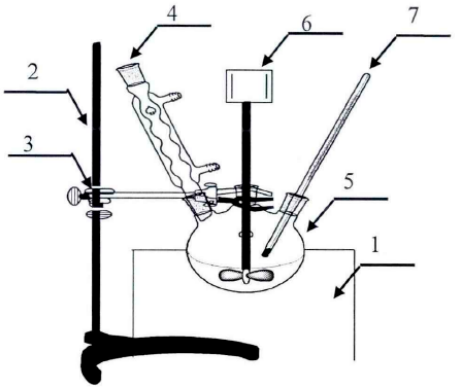
Figure 1. Diagram of three-necked glass reactor apparatus for resin synthesis (1. thermostatic water bath; 2. iron support; 3. tube holder; 4. Allihn condenser; 5. three-necked flask; 6. motor stirrer;